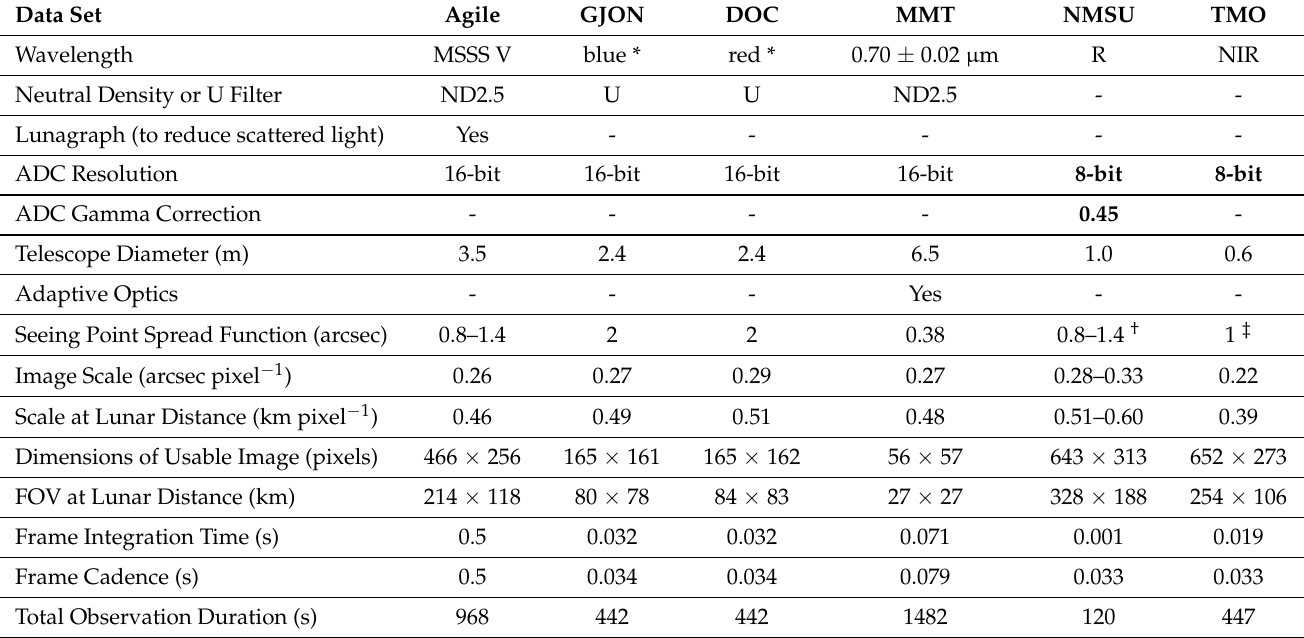
Table 1. Data acquisition attributes. The MMT, NMSU, and TMO data sets do not contain plume detections. Values marked in bold likely account for the non-detection in that data set. * Dichroic channel. † Based on Agile, which was 40 m away, and visual inspection. ‡ Based on visual